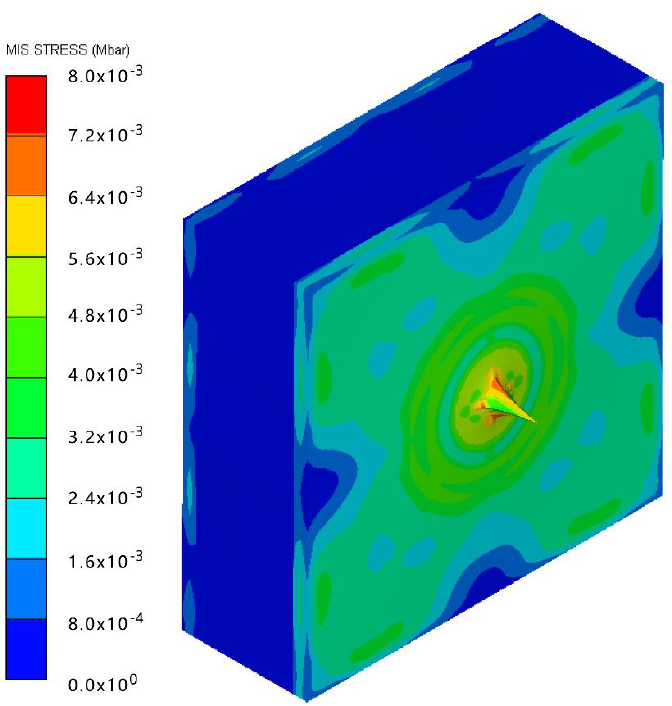
Figure 11. The contour of Von–Mises stress at the impact velocity of 500 m/s.